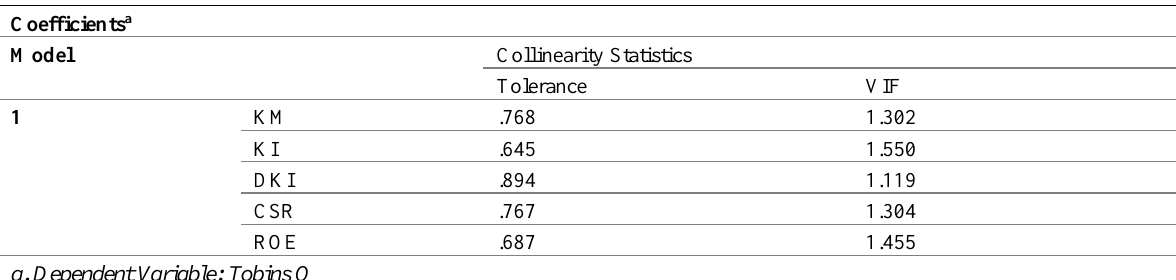
Table 2: Multicollinearity Test